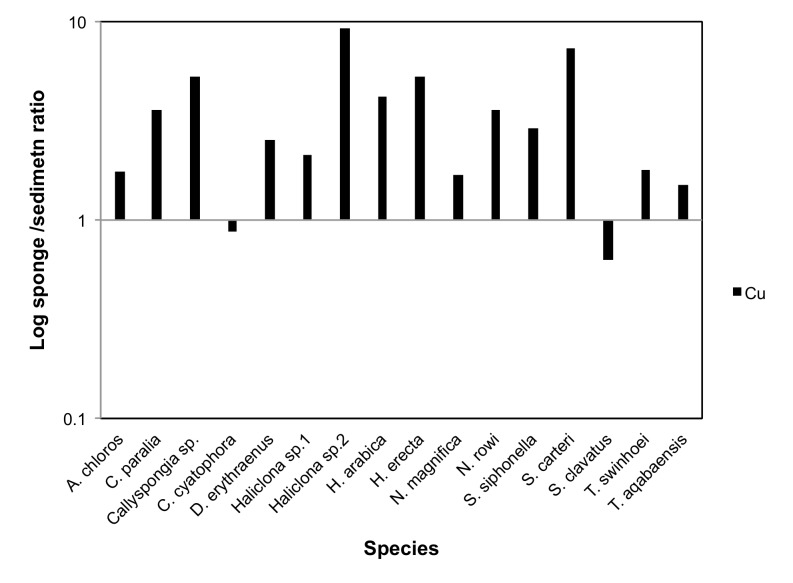
Bioconcentration factor of Cu in all sponge species compared to sediment (value set as 1).